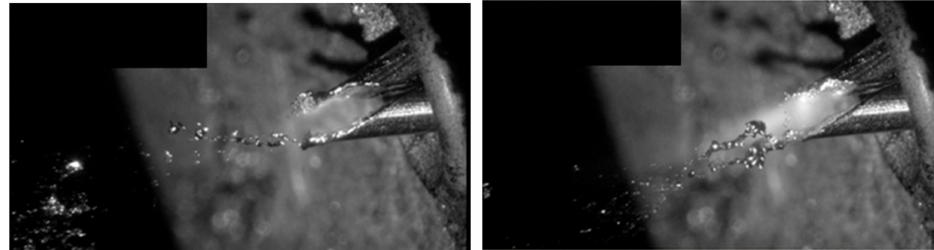
Figure 7. Particle formation during wire arc spraying with pulsed alternating current at time ( left ): t = 192.8 ms, ( right ): t = 193.4 ms.